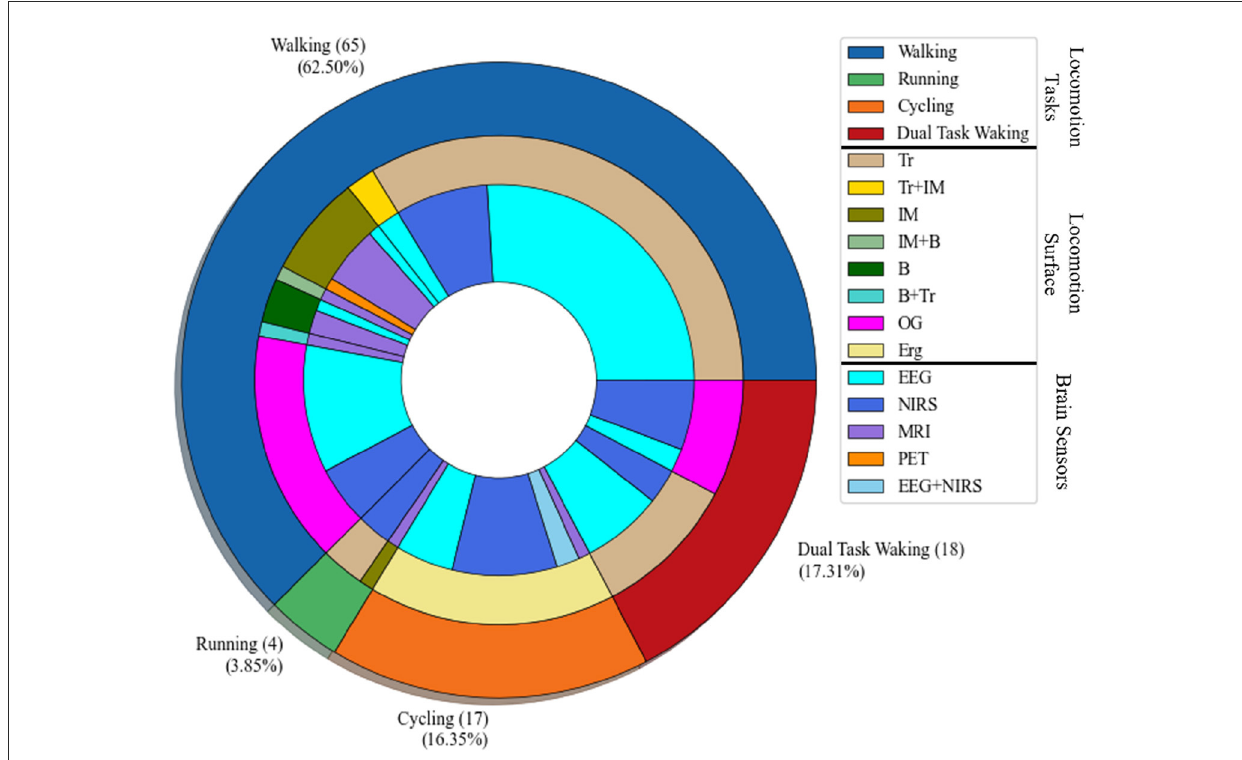
FIGURE3 Task-Surface-Brain sensor visualization: the most outer layer shows the type of the locomotion task; walking, running, cycling, and dual-task walking. The middle layer shows the type of the surface used for the body-brain imaging experiment, which are Tr: treadmill, IM: imaginary task, B: Board with pedals, OG: overground, Erg: Ergometer cycling. The most inner layer shows the type of the brain sensor used in the brain-body imaging.